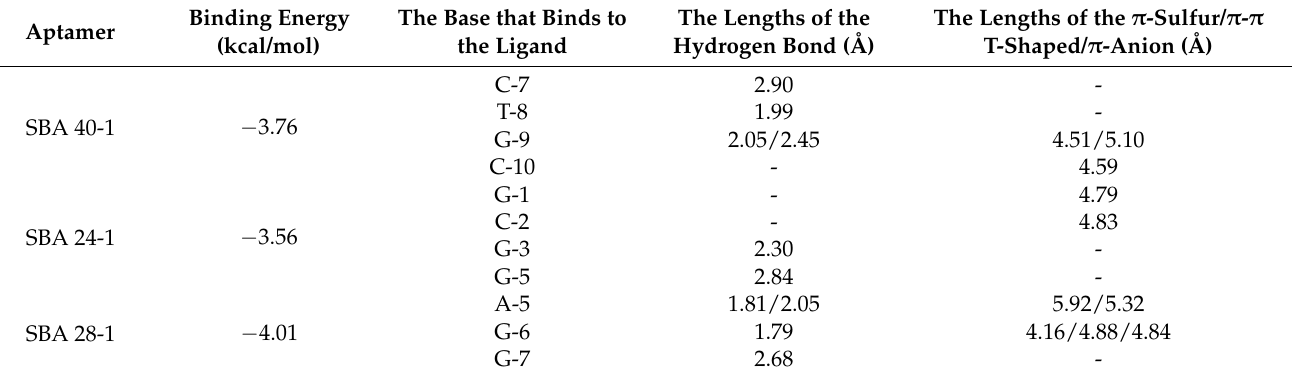
Table 1. Intermolecular interactions between DNA and the small